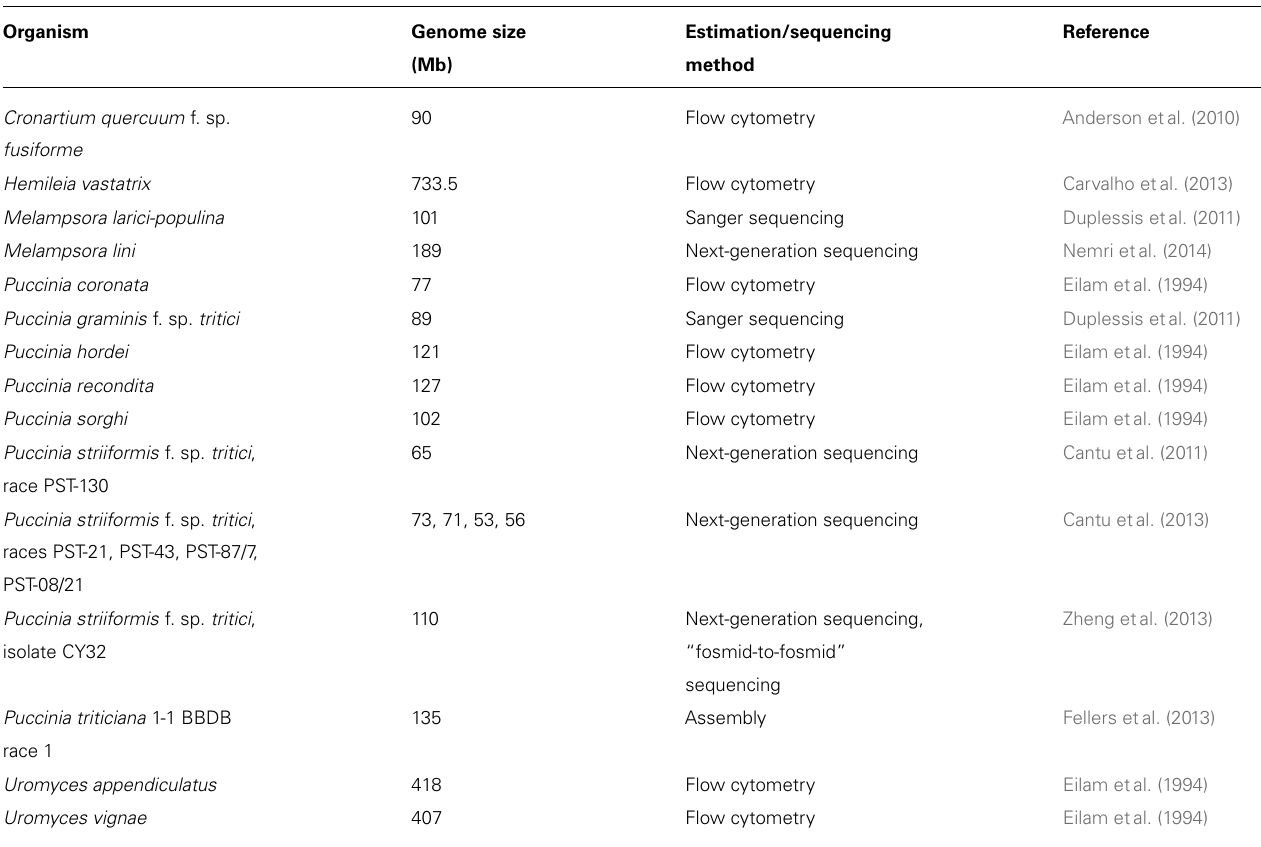
Table 1 | Published rust fungi draft genomes and genome size estimations in alphabetical order.